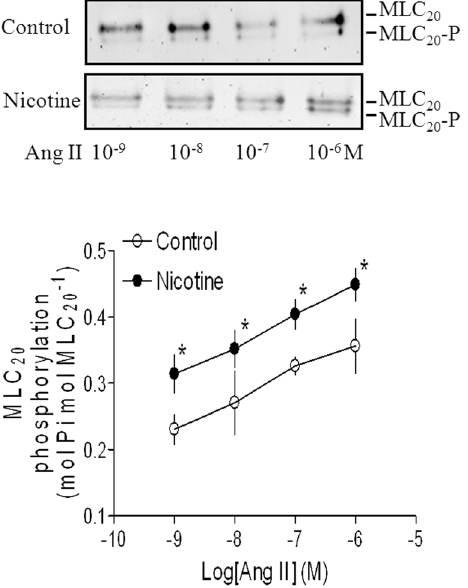
Figure 2. Effect of nicotine on Ang II-induced 20-kDa myosin light chain (MLC 20 ) phosphorylation in aortic rings in adult offspring. Aortic rings from saline control and nicotine-treated groups were stimulated with increasing doses of Ang II. Phosphorylation of MLC 20 (MLC 20 -P) was detected by Western blot (as described in METHODS). Representative immunoblot (top) shows unphosphorylated MLC 20 and phosphorylated MLC 20 (MLC 20 -P) induced by Ang II. Data are means 6 SEM of tissues from saline control (n=4) and nicotine (n=5). The sample sizes represent the animal number from different litters of each group. Data were analyzed by student t -test at each correspon- dent Ang II dose point between saline control and nicotine-treated group. * P , 0.05 vs. control.